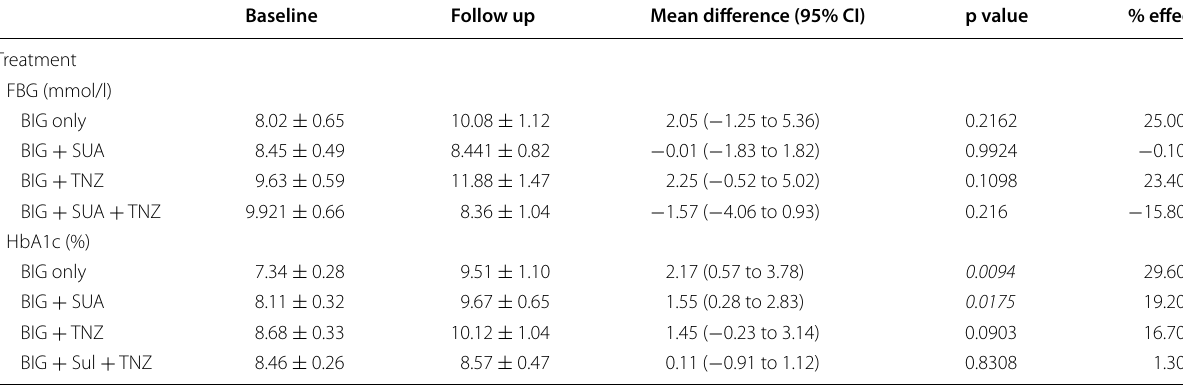
BIG Biguanide, SUA Sulfonylurea, TNZ